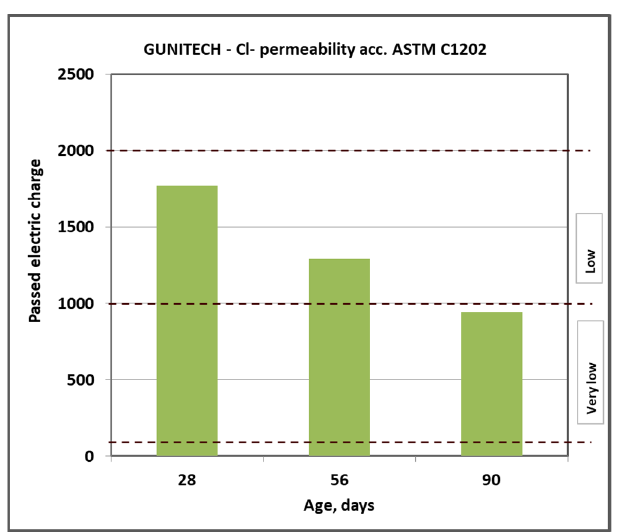
Figure 1. Chloride permeability according to ASTM C1202.